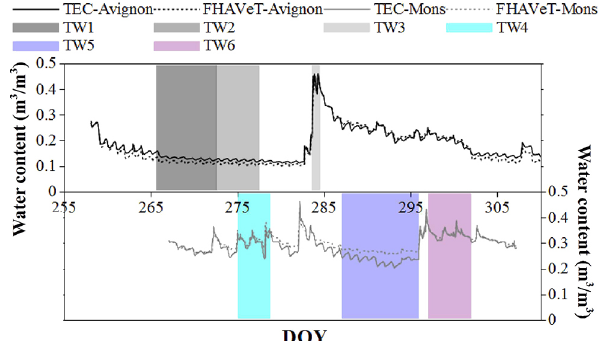
Figure 5. Soil water content evolution in time for the 0–5cm layer; comparison between models – soil AL-SiL, PTF – Wosten. Avignon climate (top) and Mons climate (bottom).